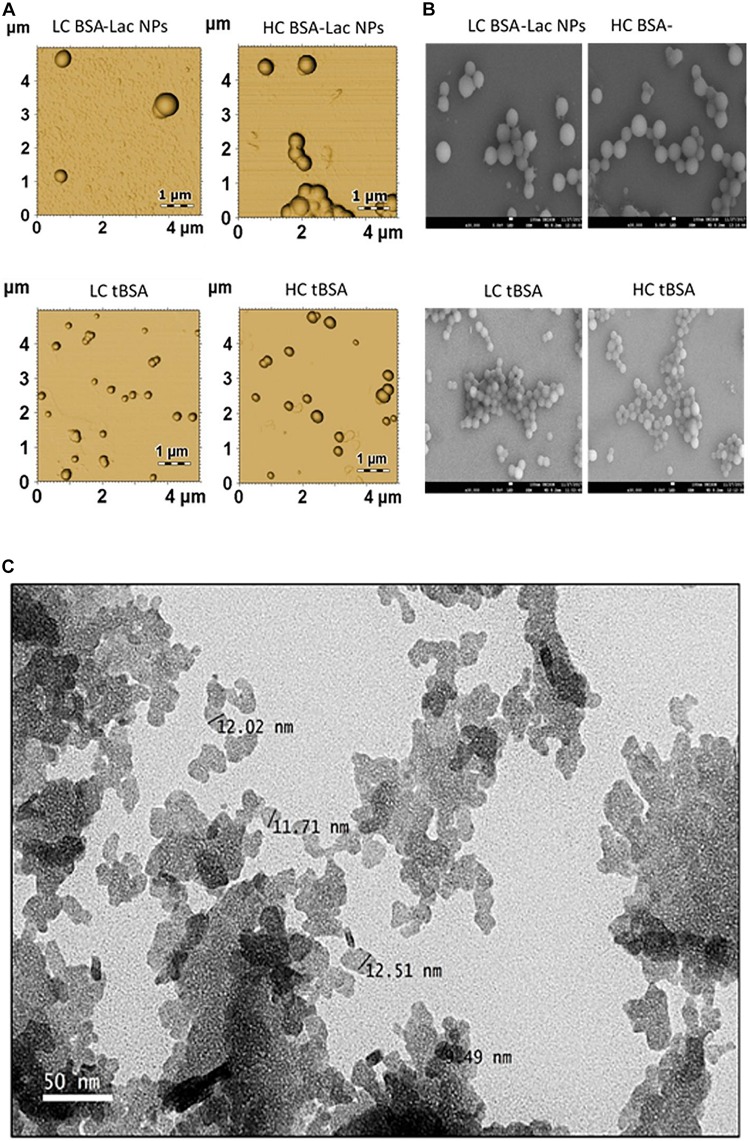
Morphology of HC and LC BSA-Lac and tBSA NPs (A) atomic force microscopy (AFM) and (B) Scanning electron microscopy (SEM). (C) Transmission electron microscopy (TEM) image of Citral-loaded self nano-emulsifying drug delivery system (CIT-SNEDDS). Adapted from Izham et al. (2019) and Teran-Saavedra et al. (2019).